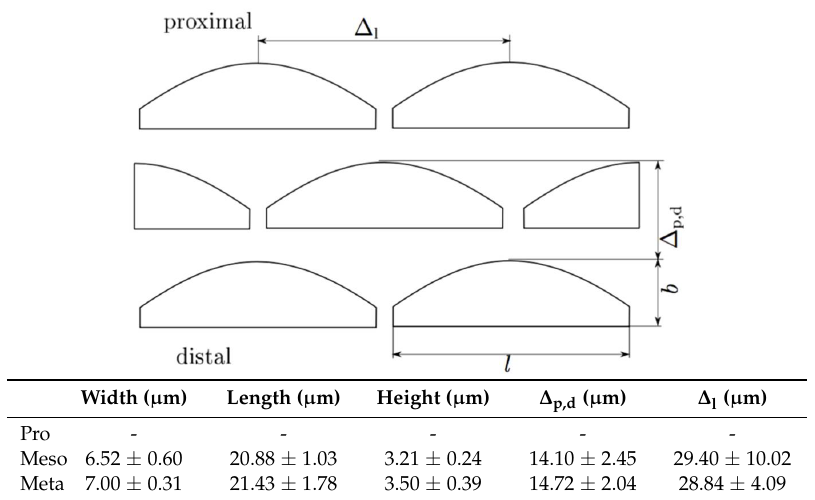
Figure 6. Roughness ( R a ) of the condyle in the femur–tibia (F d and TI p ) and the tibia–tarsus (TI d and TA p ) leg joints measured by white light interferometry (WLI). Error bars show standard deviations of the means. F d : the distal condyle of the femur; TI p : the proximal condyle of the tibia; TI d : the distal condyle of the tibia; TA p : the proximal condyle of the tarsus; pro: prothoracic leg; meso: mesothoracic leg; meta: metathoracic leg. Table 1. Dimensions of the protuberances in the distal tibia condyle of P. marginata measured with white light interferometry (WLI).